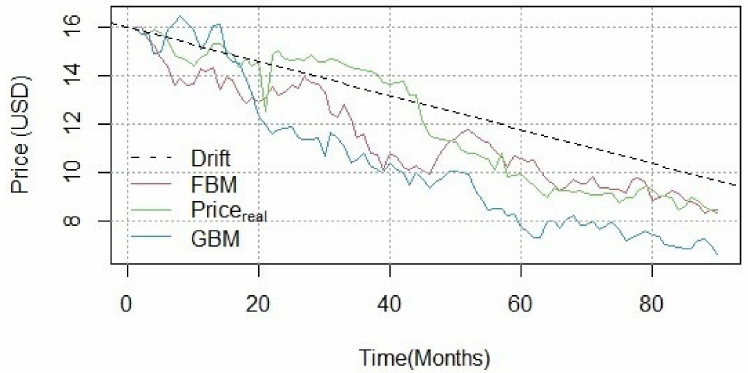
Figure 2. Simulations of the evolution of Eucalyptus wood prices following the fractional Brownian motion and the evolution through the geometric Brownian motion. The dashed line represents the slightly negative trend in prices.